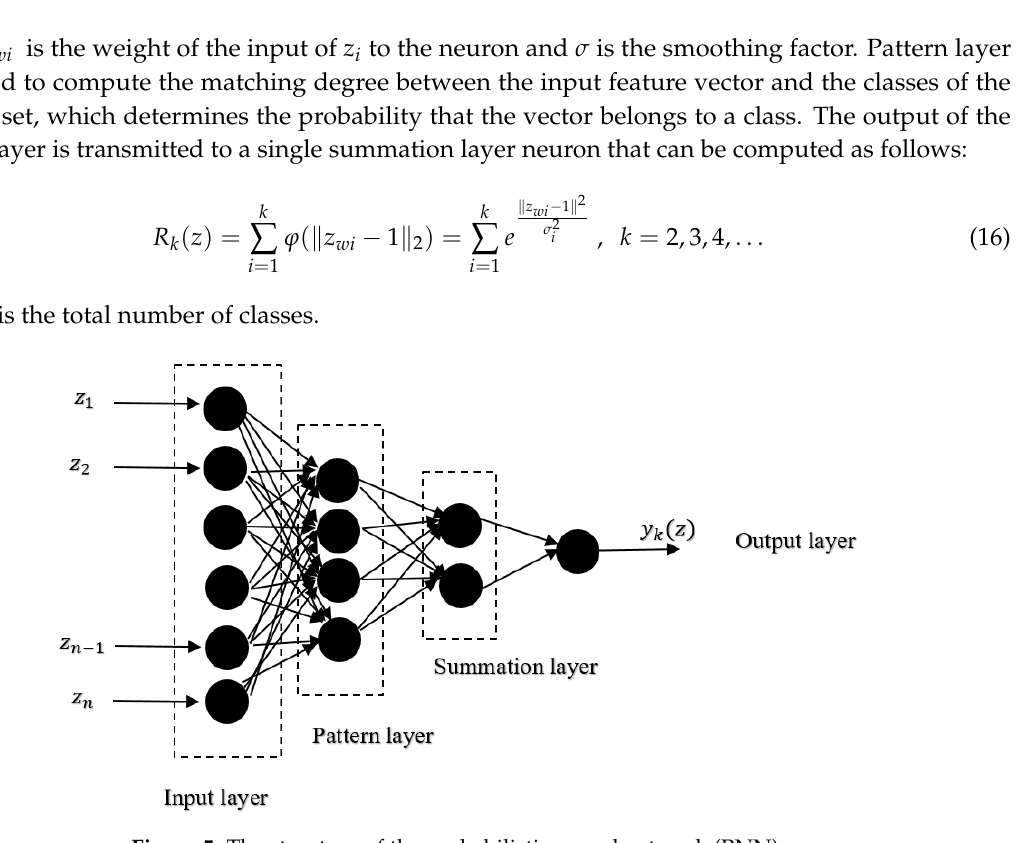
Figure 5. The structure of the probabilistic neural network (PNN).